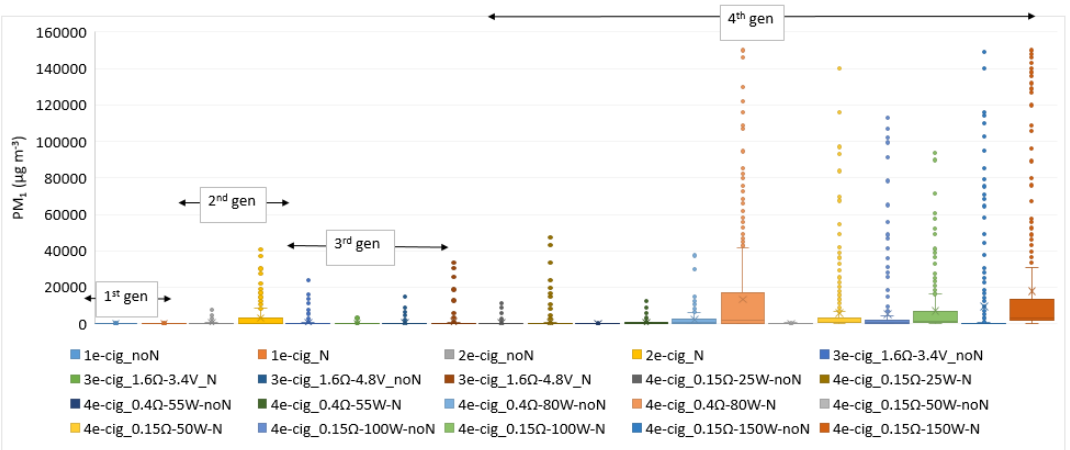
Figure 2. PM 1 concentrations ( μg m − 3 ) during all monitored vaping sessions.